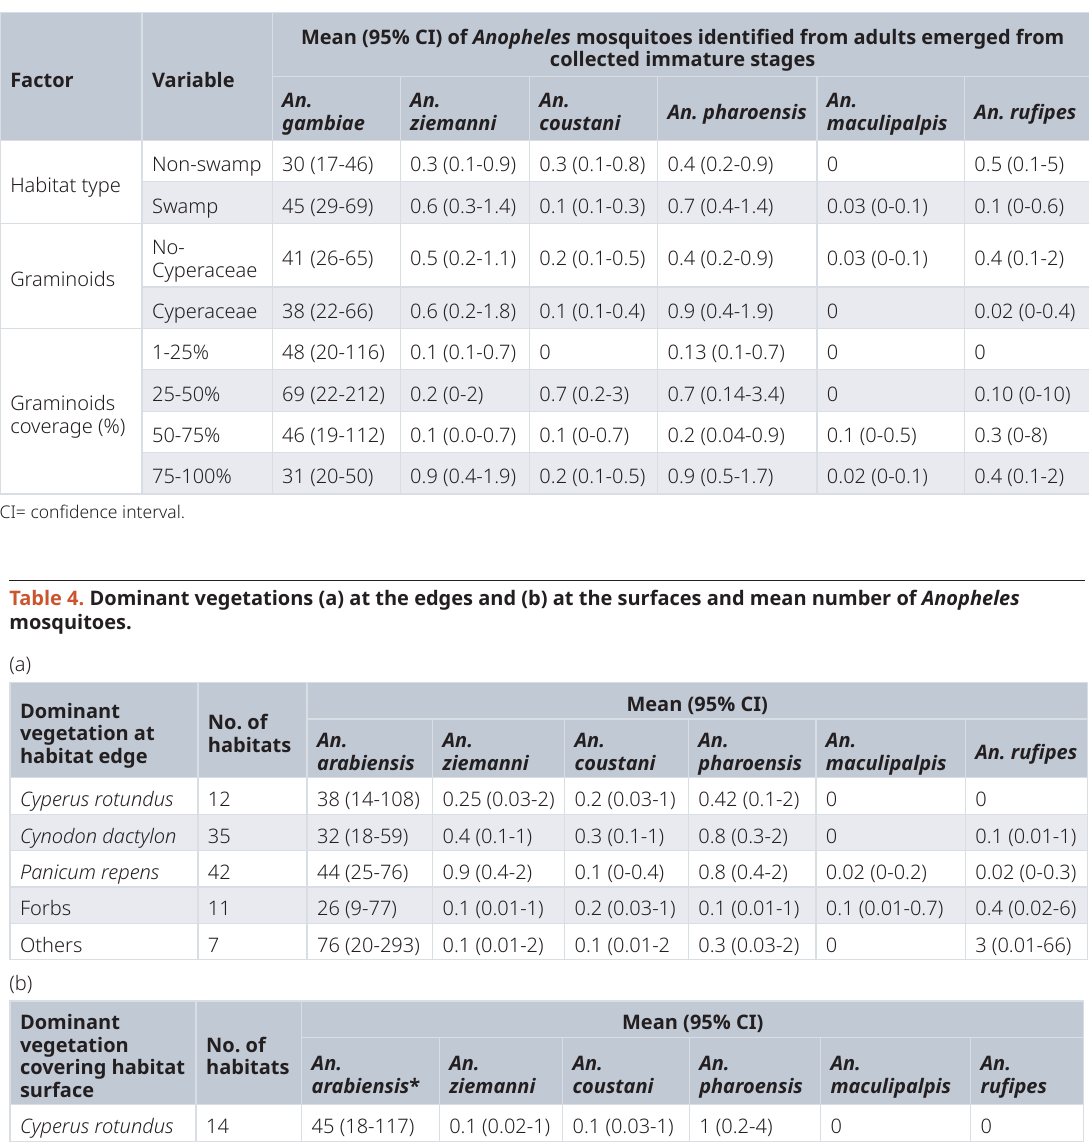
Table 3. Mean number ± 95% CI of different mosquito species in swamp and non-swamp habitats, habitats with and without Cyperaceae and graminoids coverage levels.